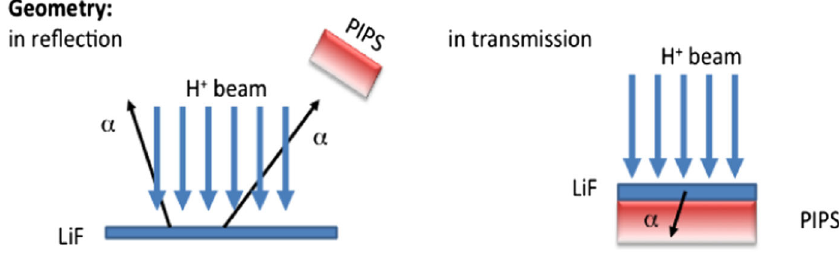
FIG. 2. Two measurement schemes (courtesy of Dr. S. Facsko, HZDR).